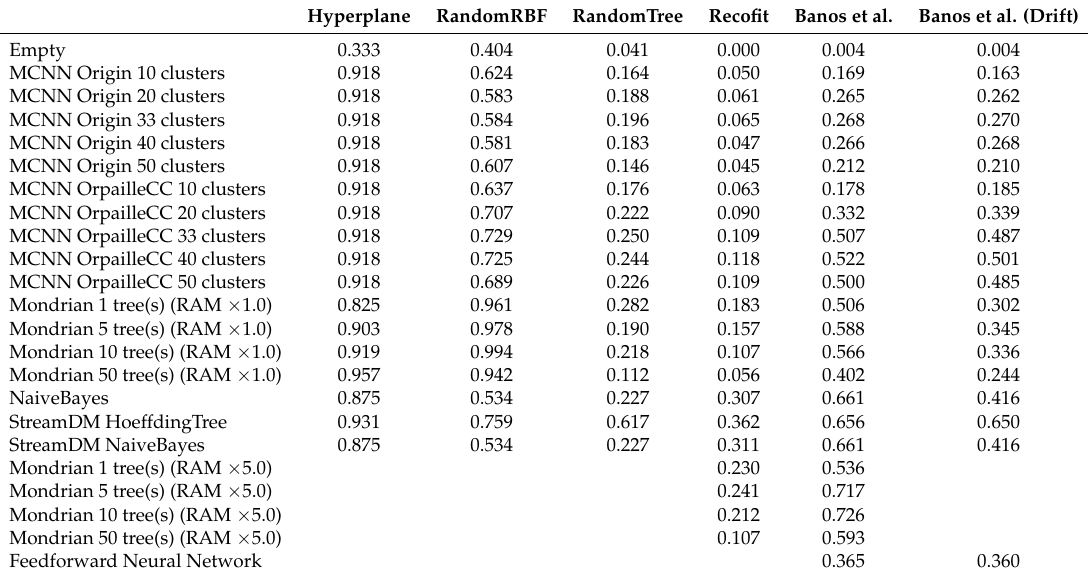
Table 3. Average F1 scores obtained on the last data point of the